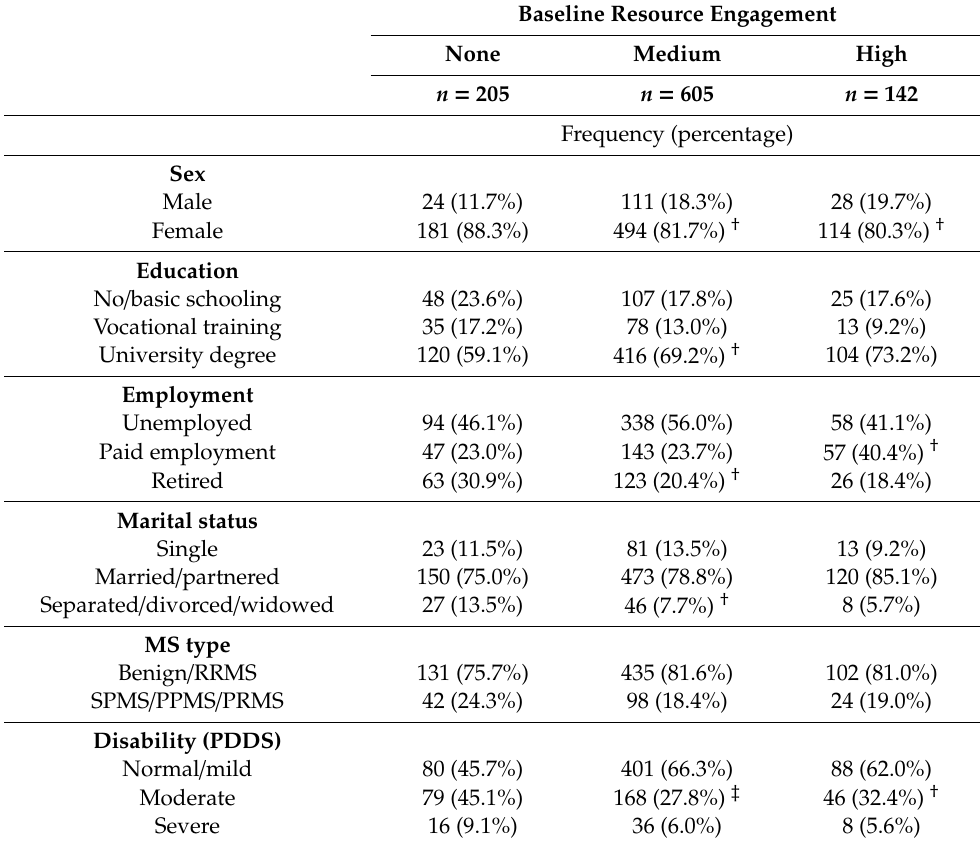
Table 2. Cohort characteristics by engagement with resources at